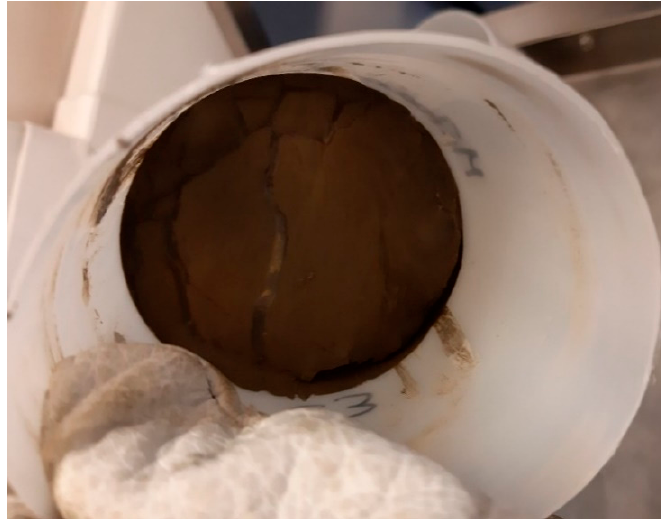
Figure 13. Consistency of Method VI, 1 day set at room temperature. For the same mixture but cured at 60 °C for 1 and 7 days, consistencies similar to a clay-silty were obtained (Figures 14 and 15).